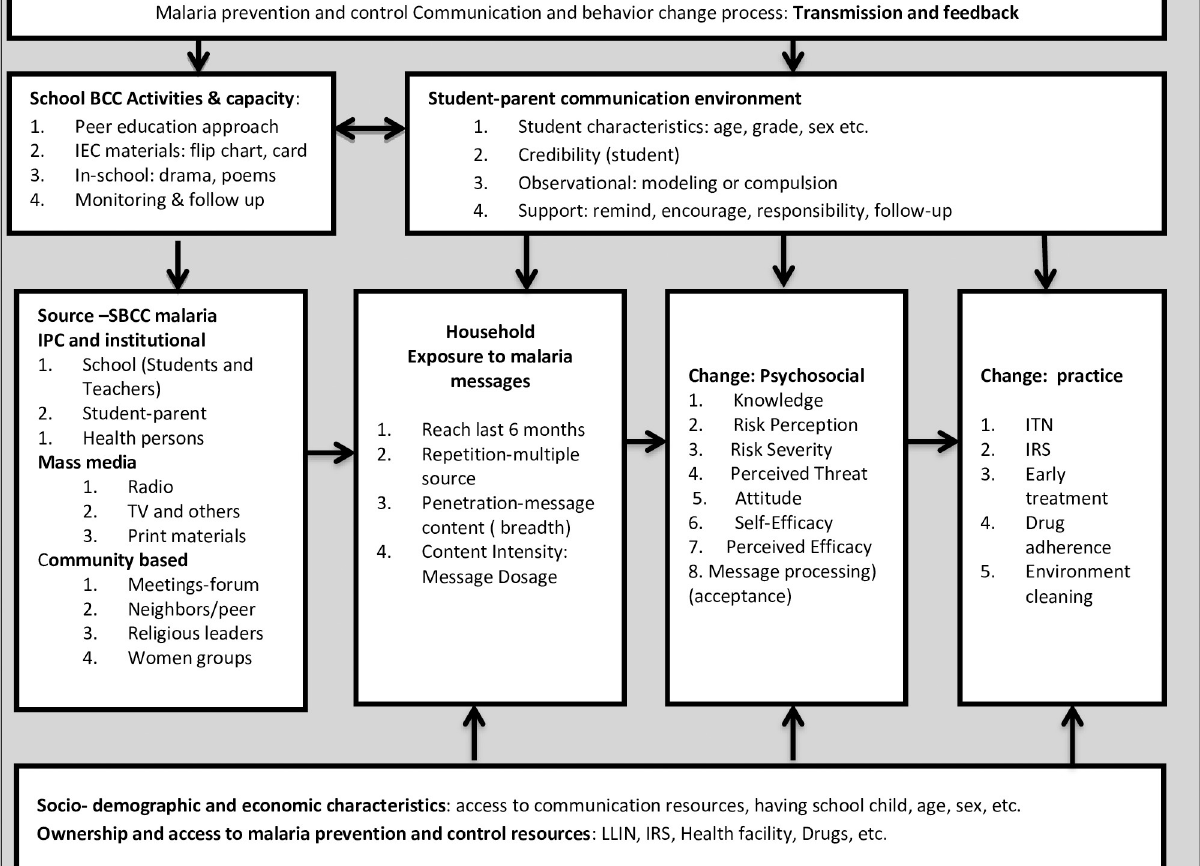
Fig 3. School-based malaria SBCC